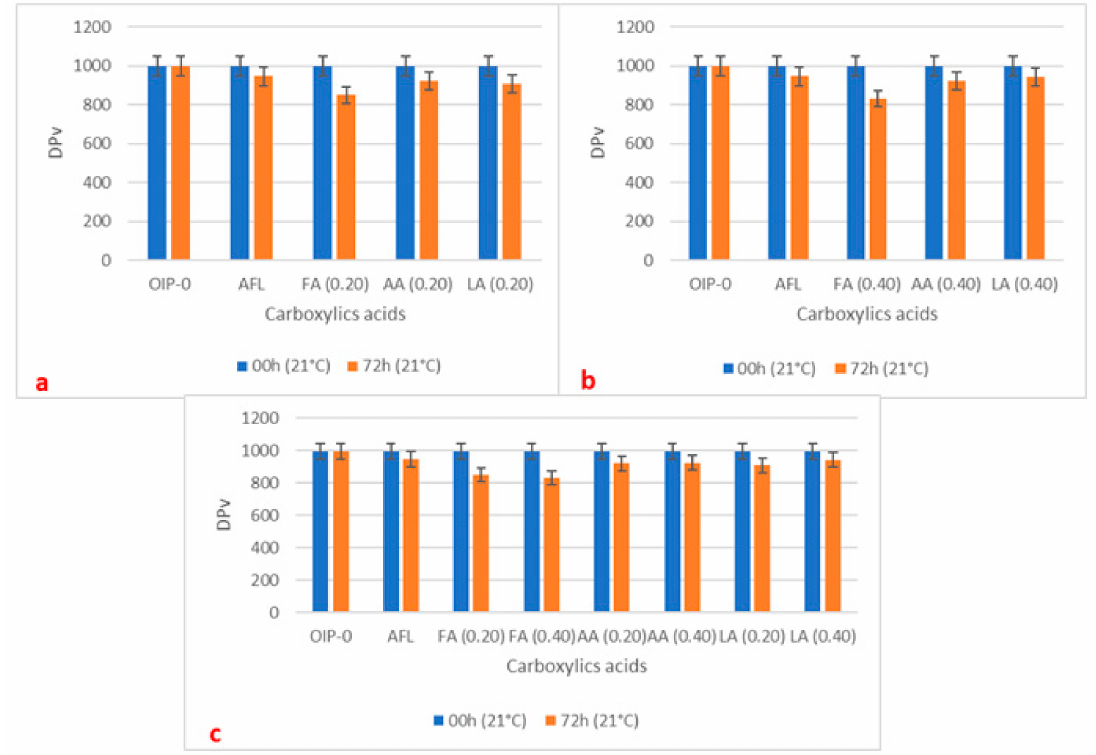
Figure 3. Degree of polymerization before and after 72 h exposure at room temperature: ( a ) 0.20 mg KOH/g and ( b ) 0.40 mg KOH/g for three different acids (formic, acetic and levulinic), acid mixture and also for acid-free oil. The results are summarized in Figure ( c ) for better